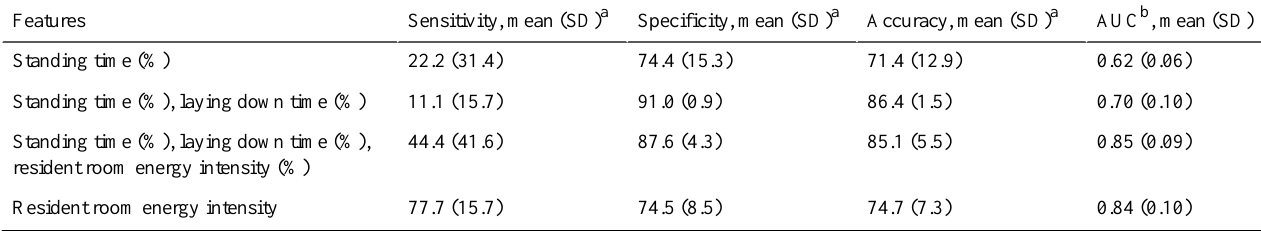
Table 7. Predictive models: 3-fold cross-validation (community, n=48; hospital,